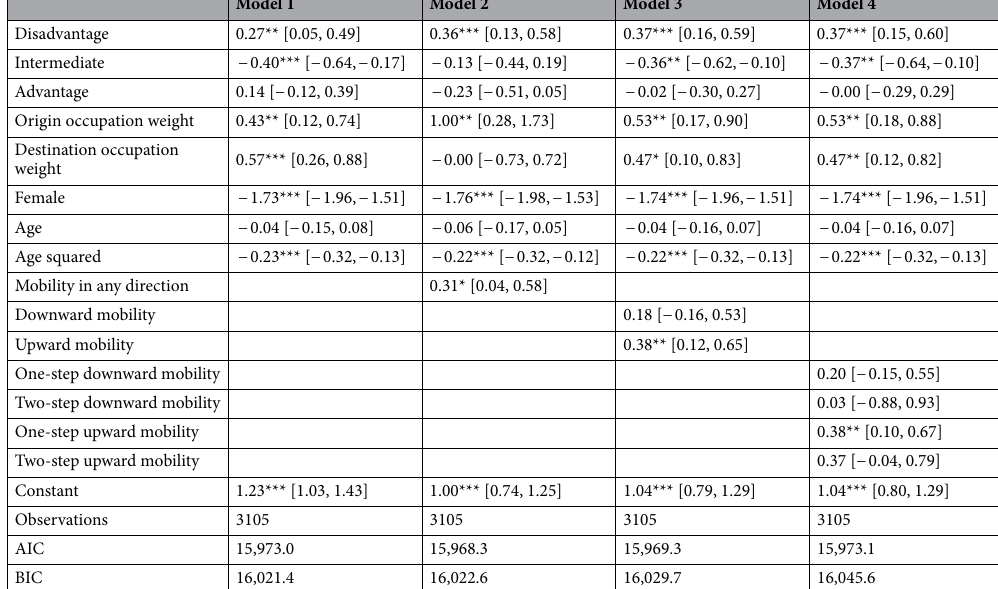
Table 4. DRM parameters estimation [95% confidence interval] for age acceleration indexed by Hannum algorithm, UK Household Longitudinal Study, 2010–2012. Models with covariates plus: (1) no mobility variable; (2) any direction mobility variable; (3) variables to indicate upward or downward trend; (4) variables to indicate one step, two step upward or downward trend. 95% confidence intervals in brackets. *p < 0.05, **p < 0.01, ***p <